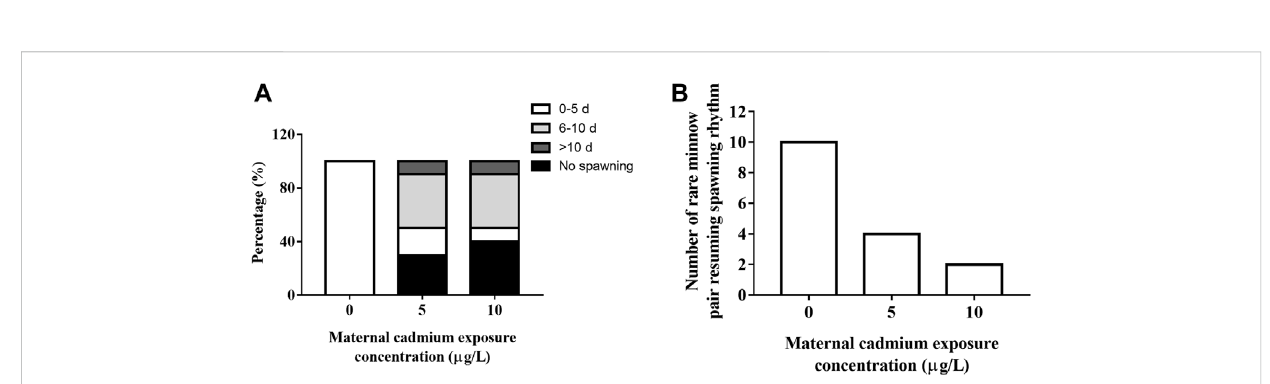
TABLE 2 Times for fi rst spawning and the average inter-spawning intervals of rare minnows ( Gobiocypris rarus ) after Cd exposure during the 28-day reproduction period. Cadmium exposure concentration ( μ g/L)